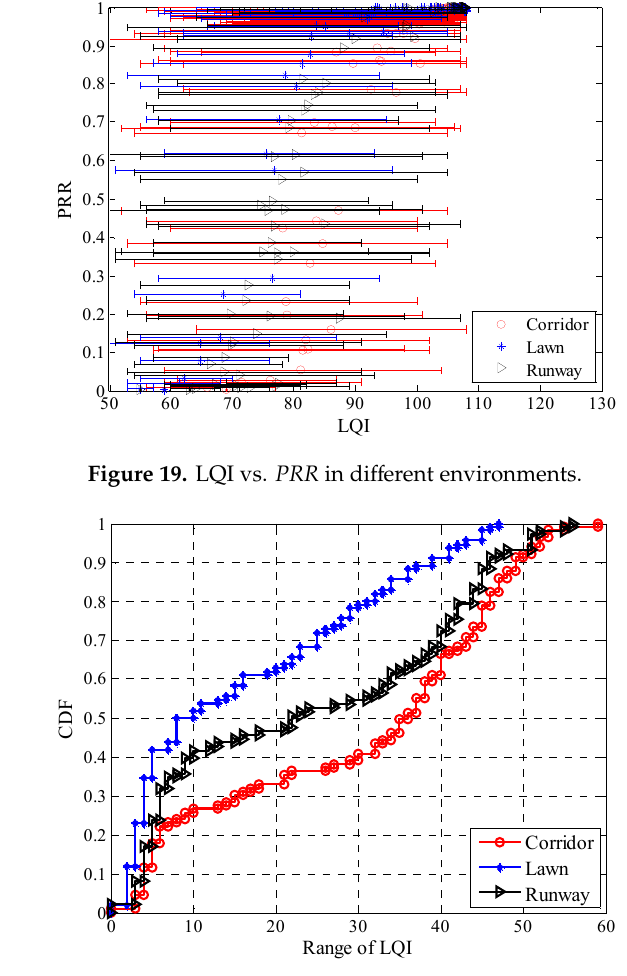
Figure 21. μ lqi vs. PRR in different environments.